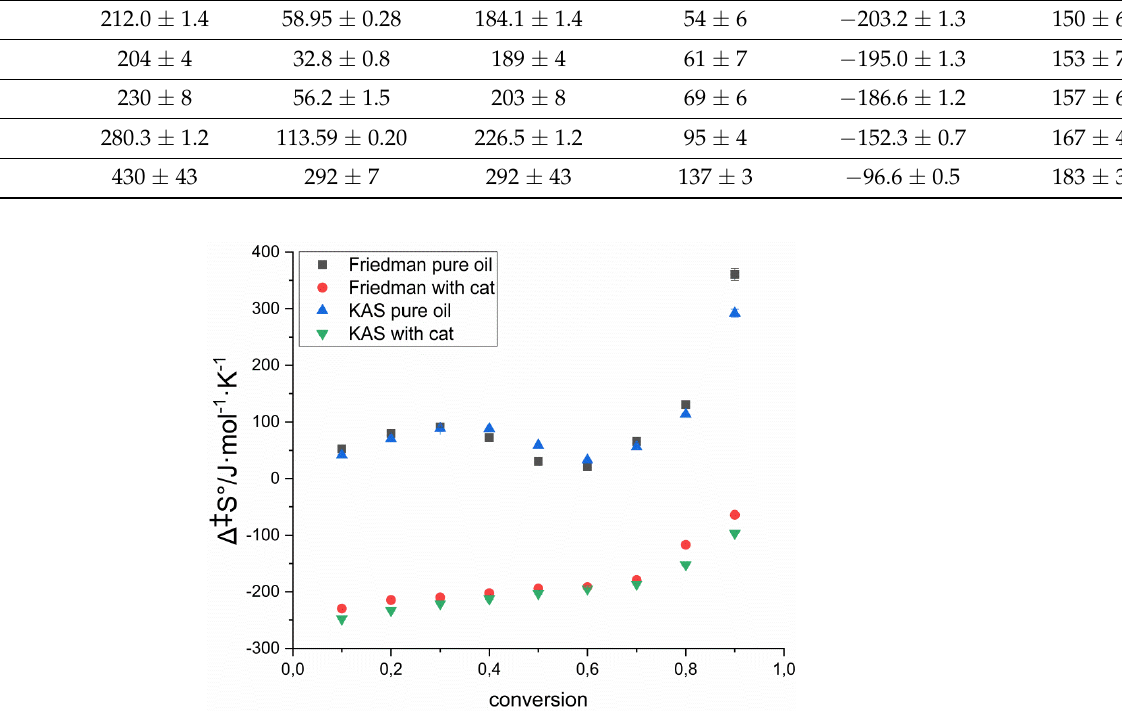
Figure 8. Dependency of the activation entropy vs. conversion for catalytic and non-catalytic peat pyrolysis.